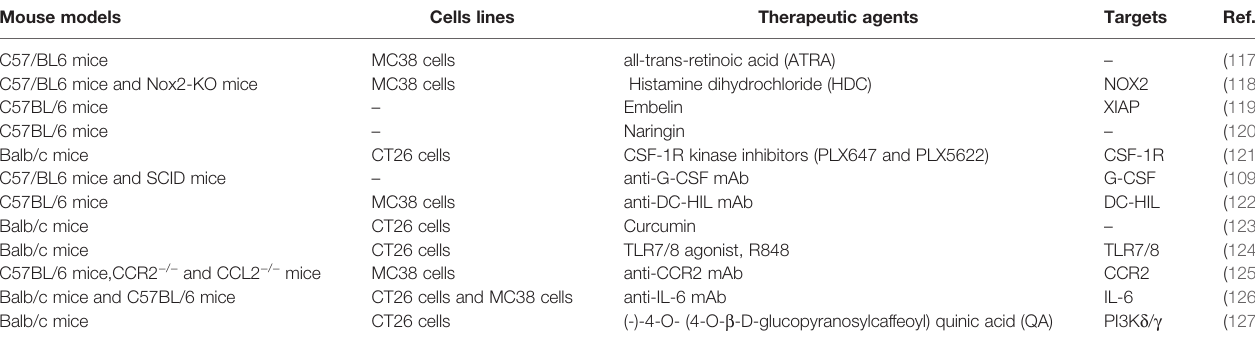
TABLE 2 | Summary of preclinical studies analyzing the role of MDSCs in CRC and therapeutic agents. Mouse